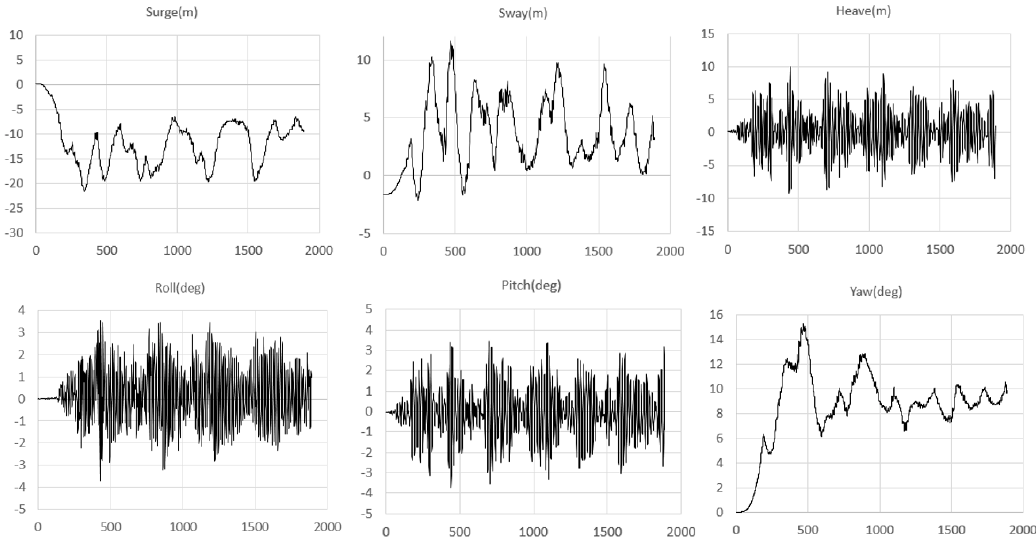
Figure 20. 6DOF Motions by Penalty Programming (Single-Alignment Thruster Configuration).